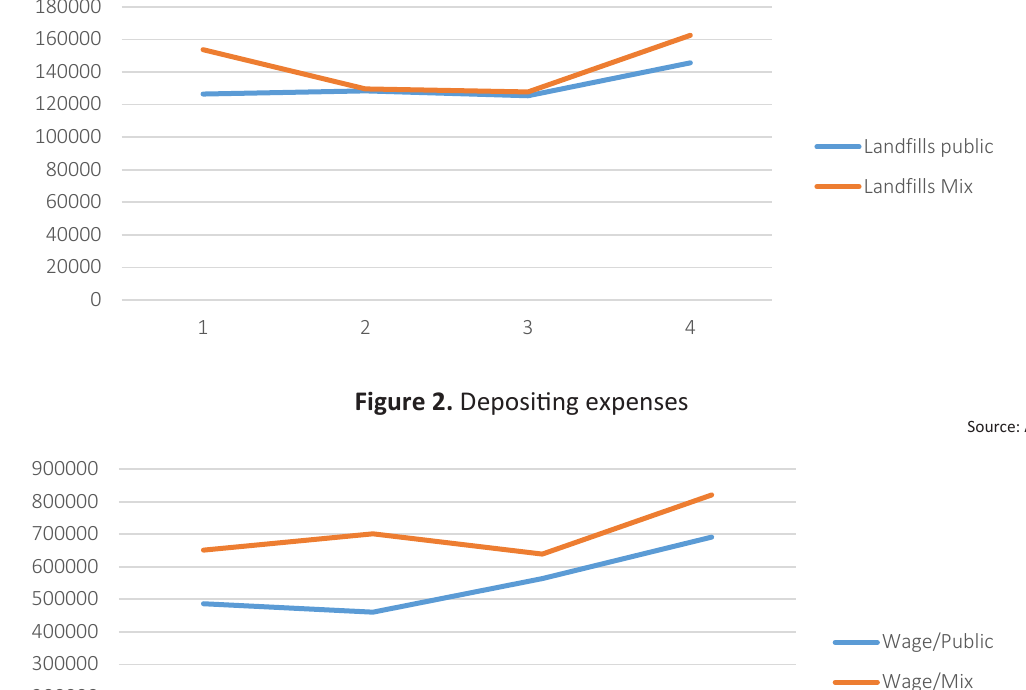
Figure 3. Wages expense